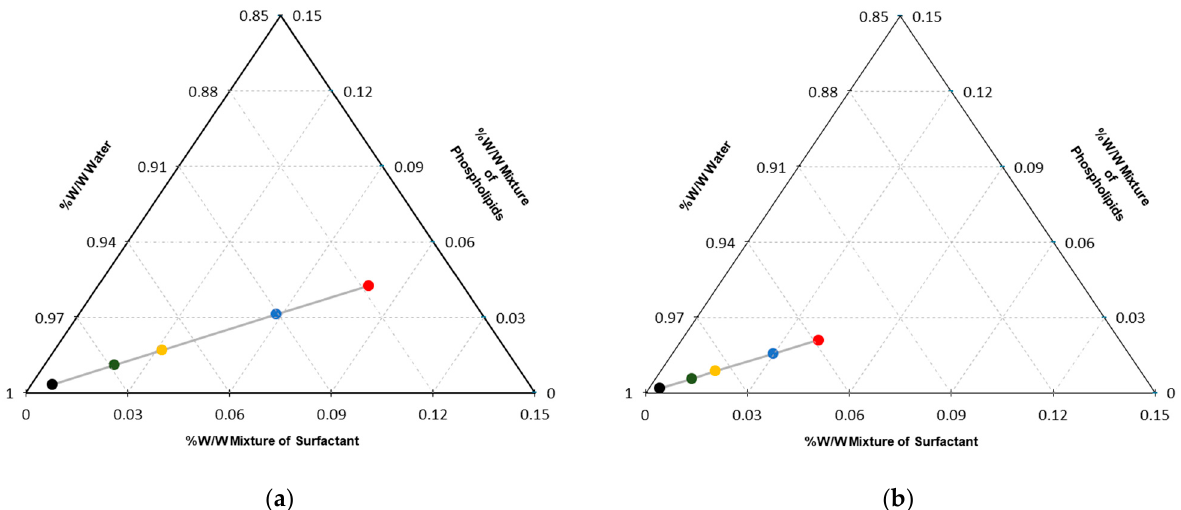
Figure 3. Pseudo-ternary phase diagrams: ( a ) the trajectories for formulation 4 and ( b ) formulation 8.